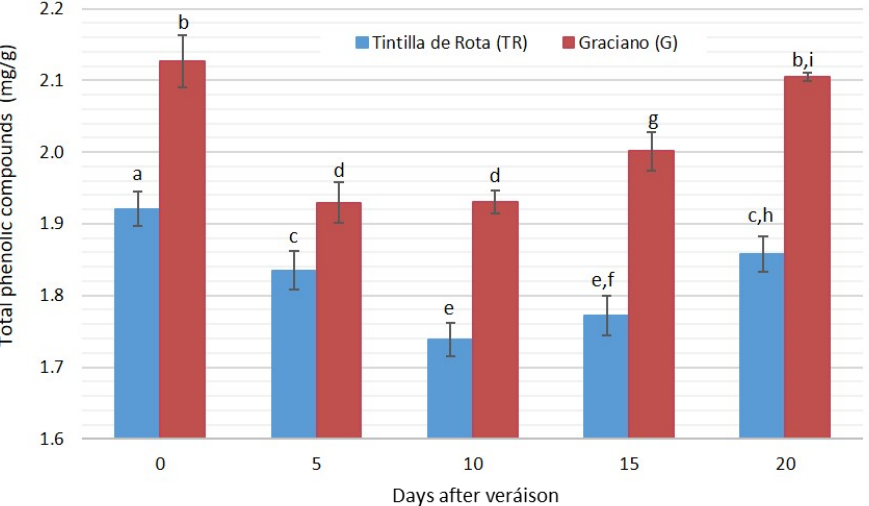
Figure 3. Evolution of total phenolic compounds (excluding anthocyanins) in ‘Tintilla de Rota’ and ‘Graciano’ accessions ( n = 3) in dry weight. Different letters mean there are significant differences between samples ( p < 0.05, two-way ANOVA, BSD test). Table 2. Phenolic compound (mg/g dry weight) (including anthocyanins) development in Tintilla de Rota and Graciano accessions during the ripening period.